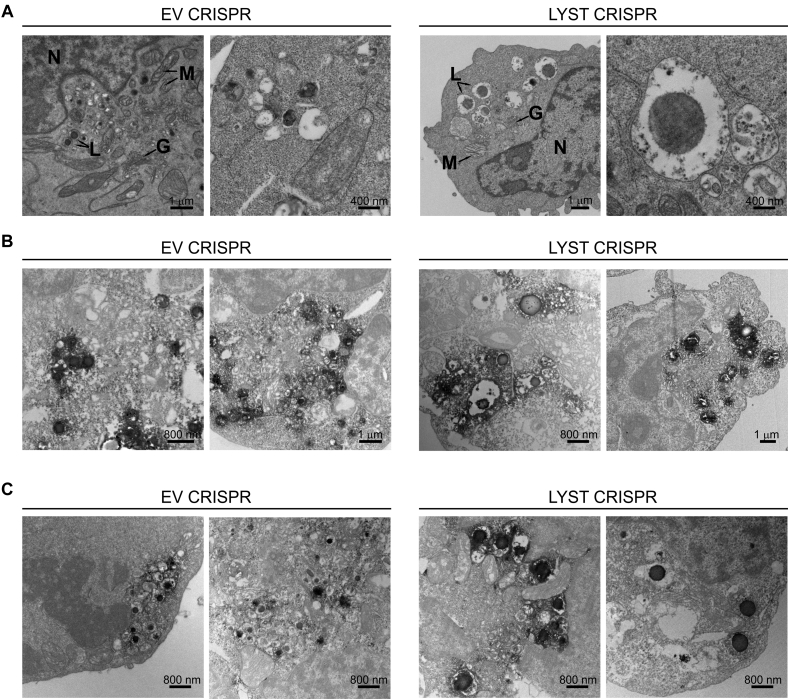
Cellular phenotype of LYST-deficient NK cells. A, Transmission electron microscopy (TEM) images illustrating the cellular ultrastructure of NK92mi cells transduced with EV or LYST CRISPR constructs. G, Golgi apparatus; L, lysosomes; M, mitochondria N, nucleus. B and C, Immunotransmission electron microscopy (Immuno-EM) of LAMP1 (Fig E1, B) or perforin (Fig E1, C) in EV CRISPR– or LYST CRISPR–transduced NK92mi cells. Images in the first columns in Fig E1, A-C, are identical to the images shown in Fig 1, A-C, and are shown enlarged for visualization purposes; images in the second column provide additional examples. Scale bar scales are indicated in the images.